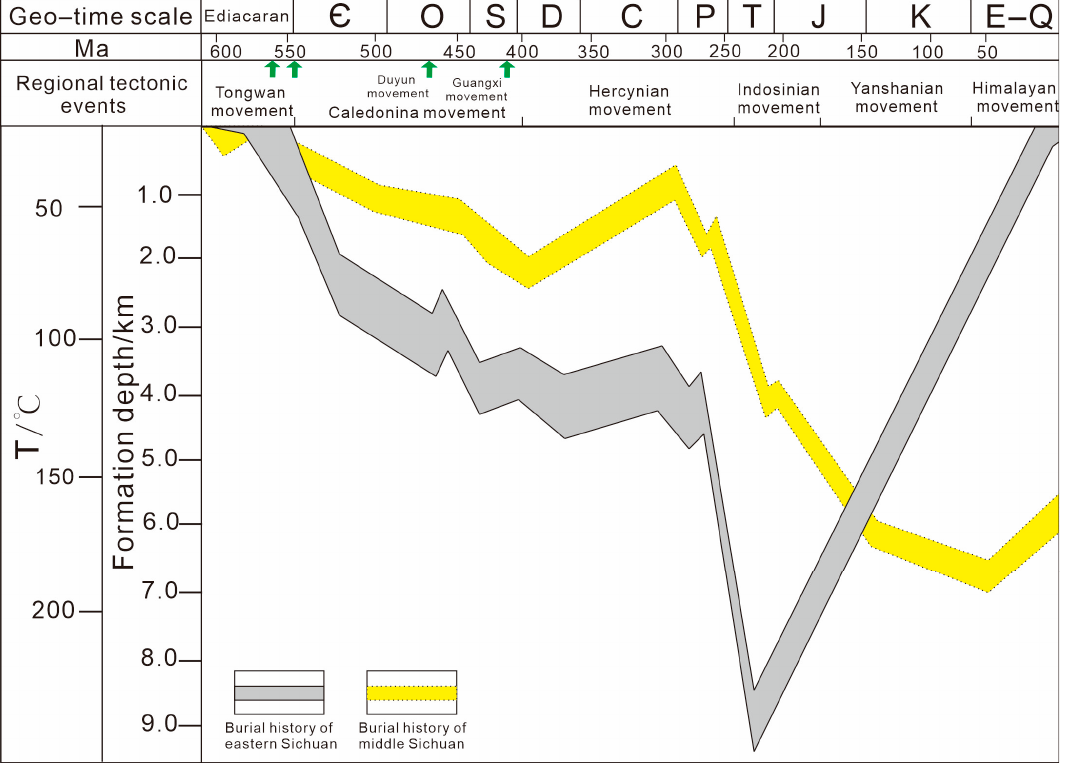
Figure 2. Typical burial history of the Ediacaran Dengying Formation, Sichuan Basin (Eastern Sichuan, modified from [44]; and for Central Sichuan is modified from [45]).